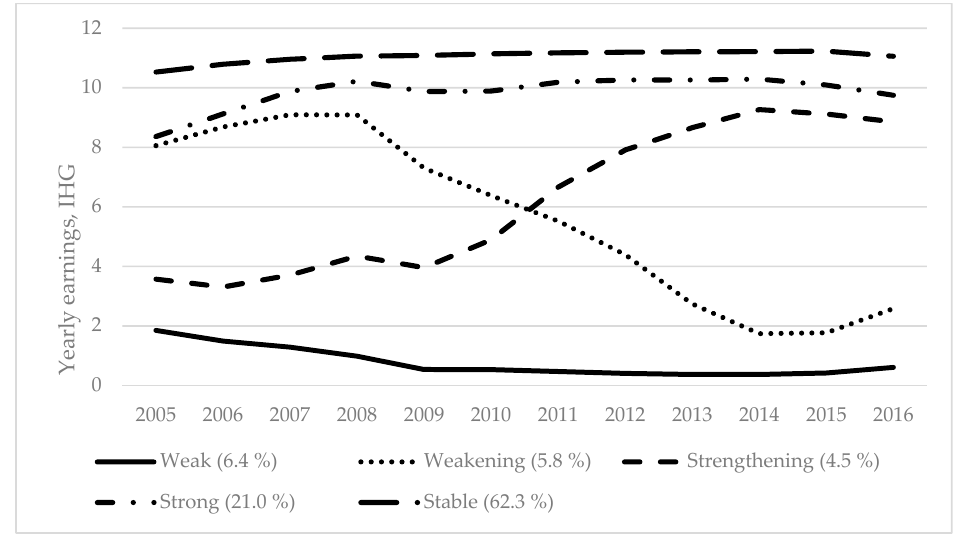
Figure 2. Men’s labour market attachment trajectories.